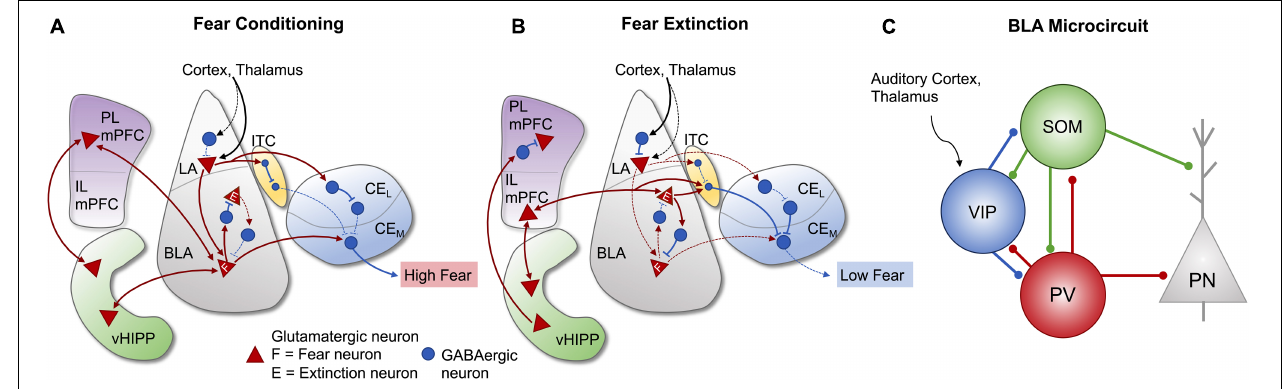
FIGURE 2 | Amygdala and corticolimbic pathways involved in fear conditioning and extinction. Strengthened and weakened connections are represented by the solid and dashed lines, respectively. (A) During fear conditioning, multimodal sensory information from the cortex and thalamus primarily converges onto lateral amygdala (LA) projection neurons and activates descending projections to fear neurons in the BLA, as well as inputs to GABAergic neurons in the intercalated cell masses (ITC). BLA fear neurons are also stimulated by projections from the ventral hippocampus (vHIPP) and prelimbic medial prefrontal cortex (PL mPFC). Output neurons in the medial division (Ce M ) of the CeA are disinhibited by GABAergic neurons in the ITC and lateral division of the central amygdala (Ce L ) and activated by BLA fear neurons, leading to high fear responses. (B) During fear extinction, incoming sensory information mostly converges onto LA inhibitory interneurons, leading to suppressed activity of LA projection neurons and decreased BLA fear neuron activity. Projections from the vHIPP inhibit PL mPFC activity and stimulate infralimbic mPFC activity (IL mPFC). The IL region activates glutamatergic extinction neurons in the BLA, which stimulate neurons in the ITC and inhibit BLA fear neurons, thus resulting in the inhibition of Ce M output neurons and reduced fear responses. (C) Organized microcircuit of feedforward inhibition in the rodent BLA regulate the activity of principal neurons (PN) under associative fear learning. VIP interneurons receiving direct inputs from the auditory cortex and thalamus are strongly activated by unexpected aversive events (US: aversive shock) and they gate information flow to a large fraction of PNs by releasing them from the strong inhibition provided by SOM and PV interneurons. There is an extended reciprocal inhibitory connectivity between all three interneuron subtypes found in the BLA. Figure adapted from Ehrlich et al. (2009), Sotres-Bayon and Quirk (2010), Sotres-Bayon et al. (2012), Lee et al. (2013), Duvarci and Pare (2014), Arruda-Carvalho and Clem (2015), Krabbe et al. (2019), and Zimmermann et al.